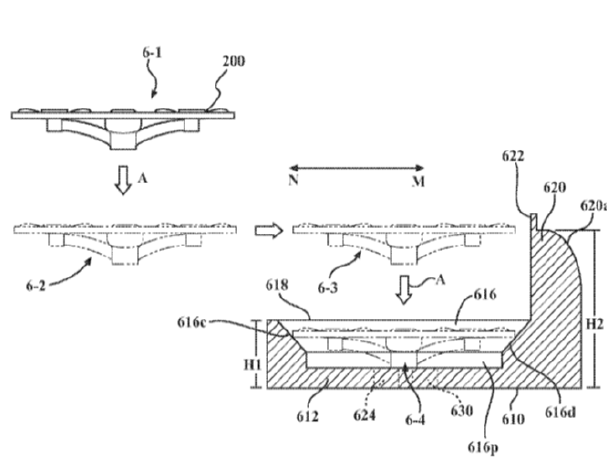
Figure 33. System for the transport, deployment, and docking of UAVs mounted on ground vehicles with a funnel for the whole UAV body [87] by Toyota Motor Corp. 200, UAV; 610, landing platform body; 616, centering funnel; 616r, funnel; repeating the body of the UAV; 618, inlet opening.